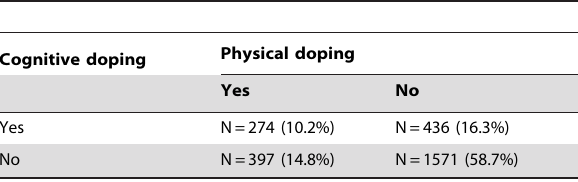
Table 11. Cross tabulation for the RRT answers concerning physical and cognitive